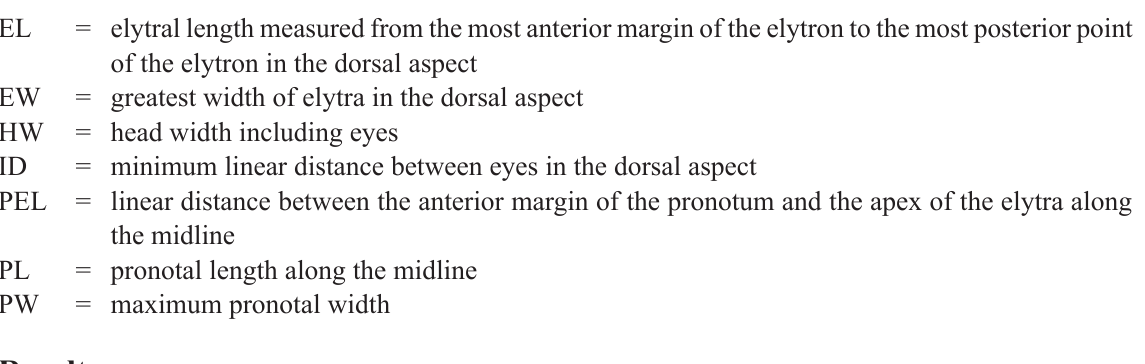
FigTree ver. 1.2.3 ( http://tree.bio.ed.ac.uk/software/figtree/ ). Finally, pairwise uncorrected p -distances of 18S, ArgK, and COI nucleotide sequences of Potamophilus spp. and Potamophilinus sp. were